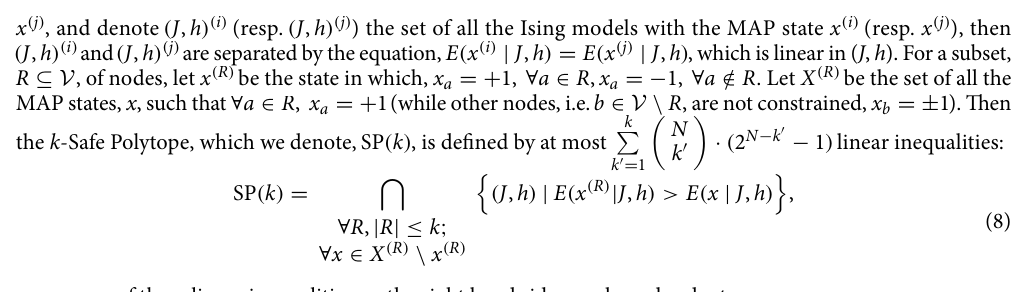
Figure 2. Geometry of MAP states for Ising on K 3